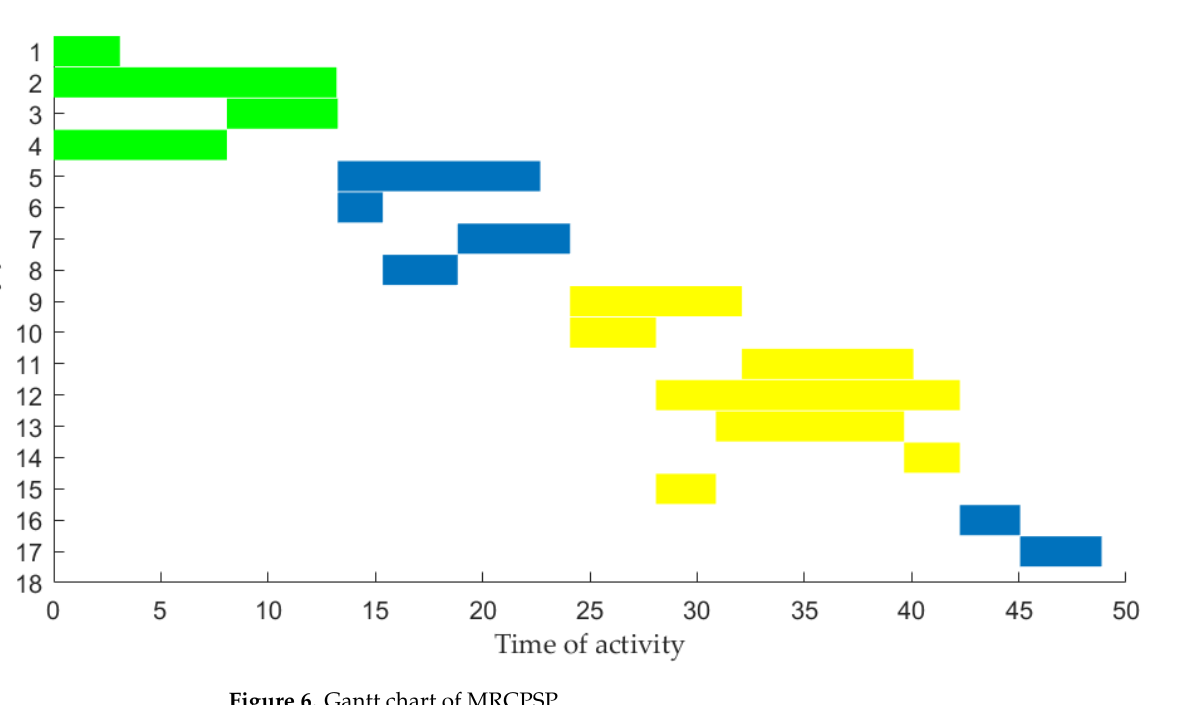
Figure 6. Gantt chart of MRCPSP. Table 8. Resource transportation decision.